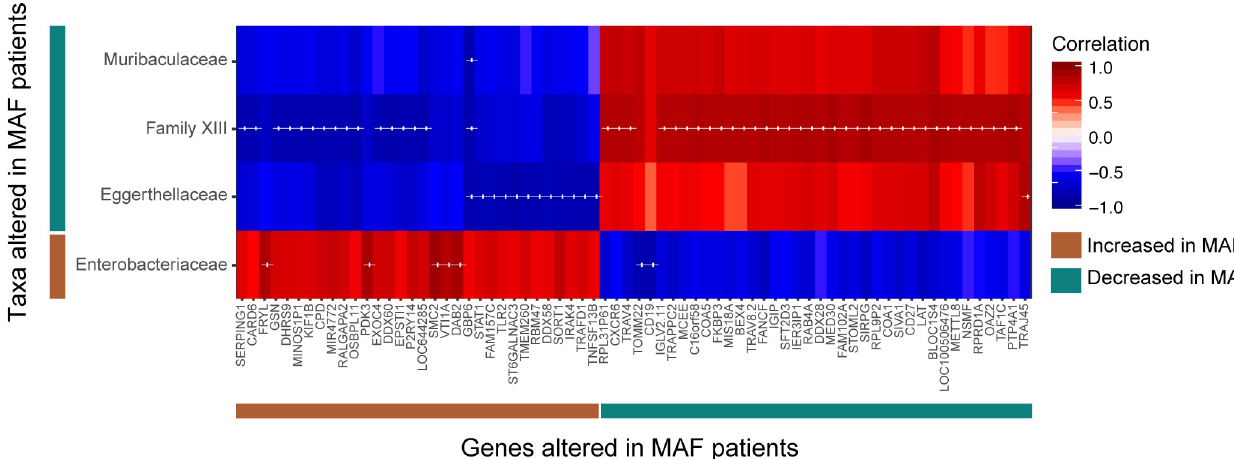
Fig 5. Correlation analysis between blood transcriptome profile and intestinal microbiome composition. Spearman correlation analyses was performed on a pool of 9 healthy and 8 MAF-infected subjects comparing the normalized expression of ~1600 immune-pathway related genes with the relative abundance of 13 bacterial families both parameters of which were altered during MAF infection in comparison to healthy individuals. These altered genes/ taxa are identified as indicated in the key. Genes and taxa that had at least one significant correlation following Benjamini-Hochberg correction were selected. Unsupervised hierarchical clustering was performed on this correlation matrix and displayed as a heatmap. Red and blue indicate positive and negative correlations as indicated in the key. ‘+’ indicates a correlation with adjusted p-value ≦ 0.018 and was chosen instead of p < 0.05 for clearer